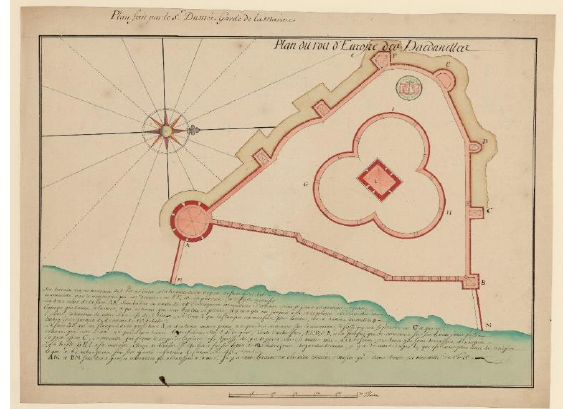
Figure 01 : Map of 18th Century Dardanelles Strait, National Library of France, Map and Planning Department, GE C- 4074.